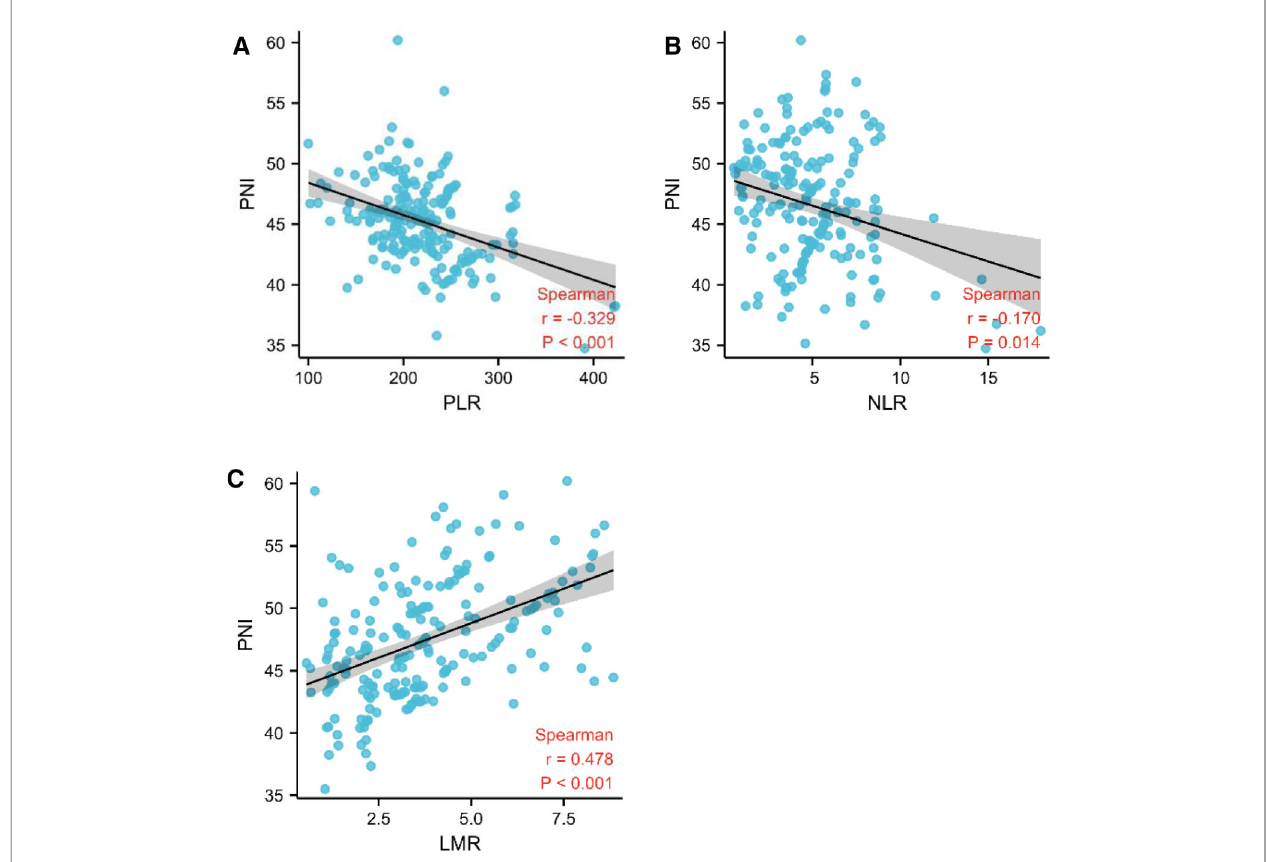
FIGURE 2 | PNI was linked to the systemic in fl ammatory responsive marks. ( A – C ) Association between PNI and PLR, NLR, and LMR using Spearman ’ s